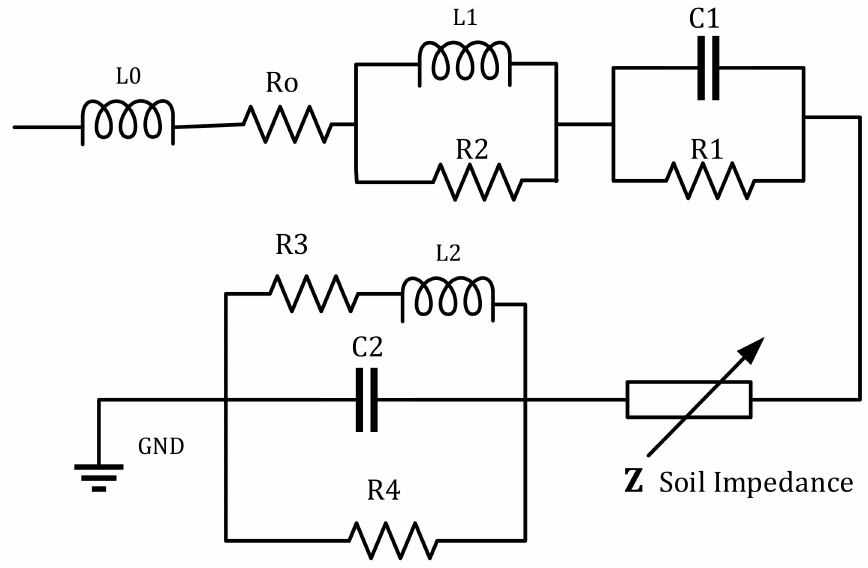
Figure 2. Equivalent electrical circuit with soil impedance of grounding system.